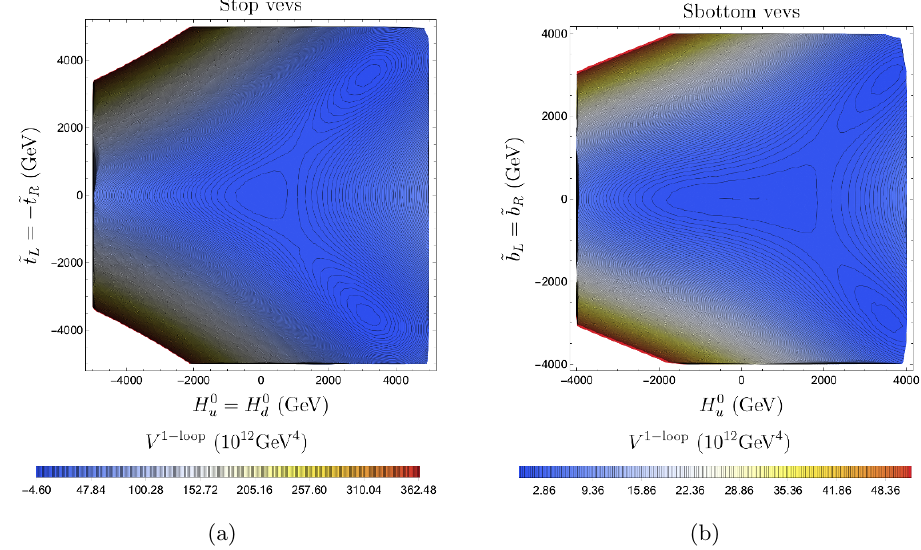
Figure 2 . The encircled closed contours surround the minima of the potential. The central contour encloses the DSB minima, while the other two contours that encircle regions with non-zero vevs for stops (sbottoms) in (cid:12)gures 2(a) ((cid:12)gure 2(b)) represent the global CCB